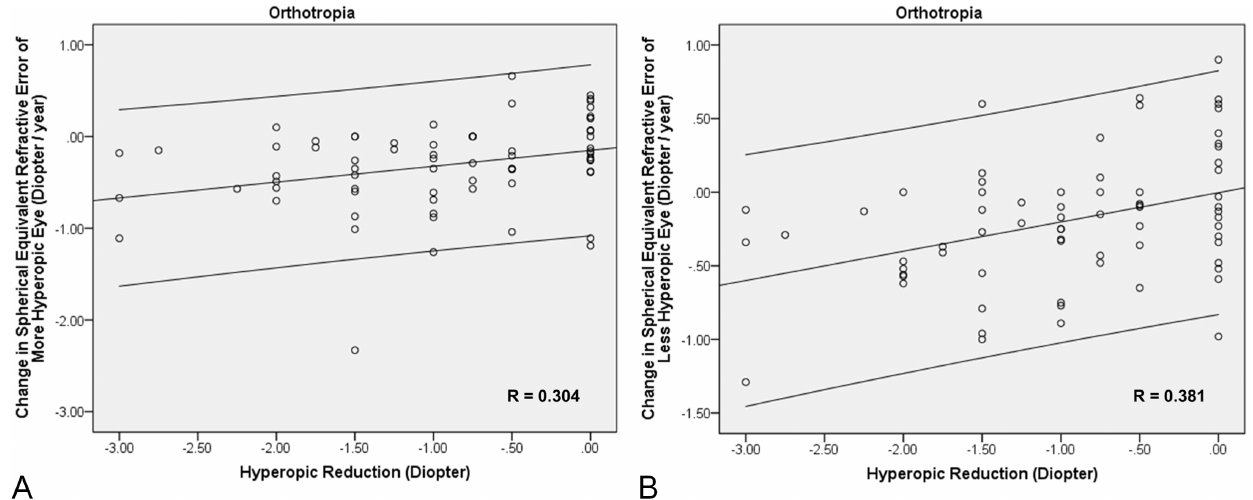
Figure 1. In the subgroup of orthotropic patients with hyperopia who received full or undercorrection of hyperopia, there was a positive correlation between the amount of undercorrection and the magnitude of change in hyperopia (A) in the more hyperopic eye (r=0.304, R 2 =0.092, P= 0.011, y= 2 0.15 + 0.17*x) and (B) in the less hyperopic eye (r=0.381, R 2 =0.145, P =0.001, y= 2 2.96E– 3 + 0.2*x).